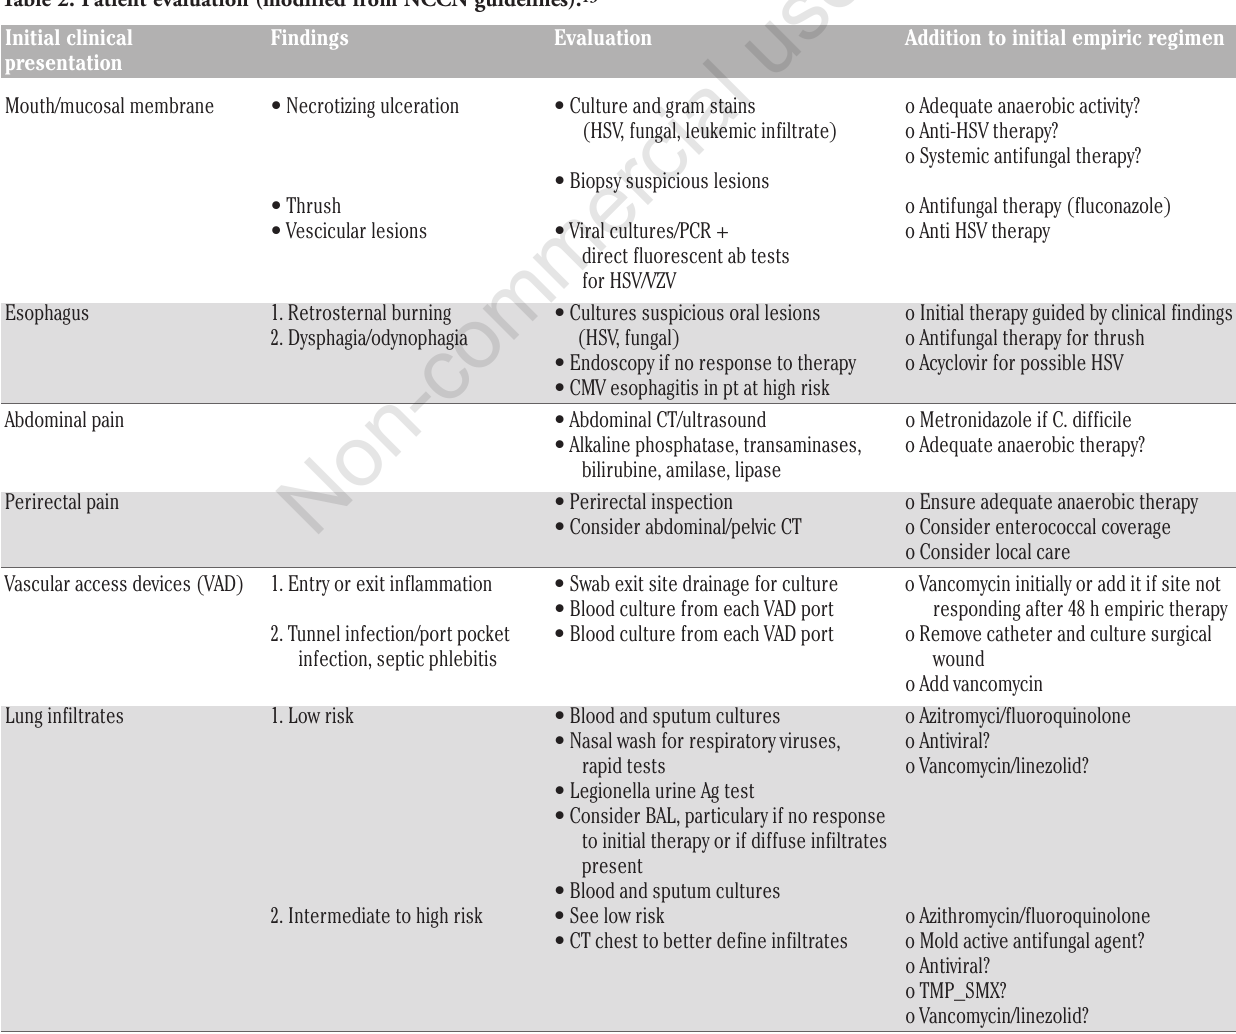
Table 2. Patient evaluation (modified from NCCN guidelines). 13